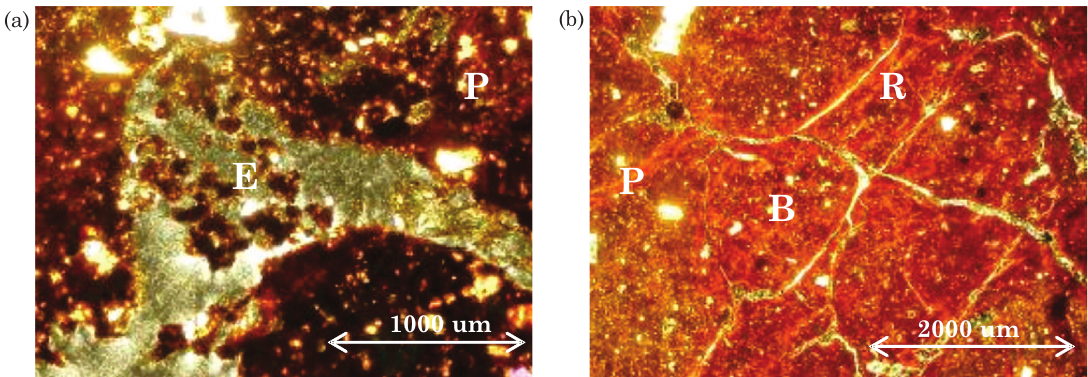
Figura 2. Fotomicrografias em luz polarizada cruzada (XPL) do P1. a) Feições de excremento em canal (E) e distribuição relativa porfírica aberta (P), no horizonte Ap. b) Microestrutura em blocos subangulares